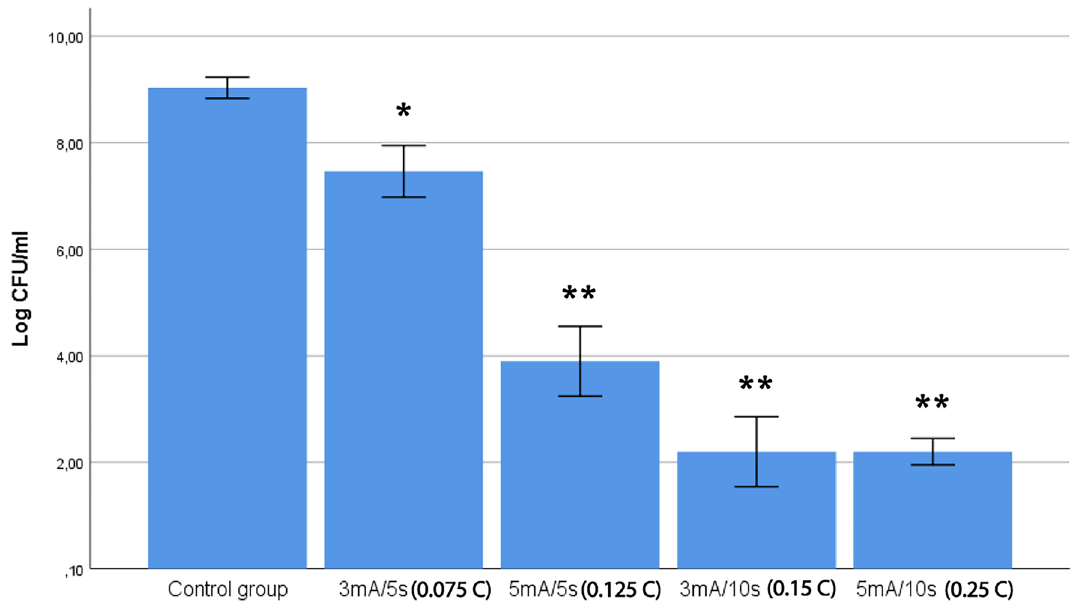
Figure 5. Relevance of the dose of the galvanic currents on the bactericidal effect on S. aureus . Data were expressed as mean with CI of the number of viable log 10 CFU/ml. NE parameters were expressed as “intensity (mA)/ time (seconds)”. Two different intensities (3 and 5 mA) and times (5 and 10 s) were selected, always applying five consecutive impacts to the bacterial suspensions on a 14 G tri-beveled needle (2.2 mm × 50 mm). Doses were expressed in Coulombs (C). (*: statistical significance p < 0.05 in relation to the control group; **: statistical significance p < 0.001 in relation to control